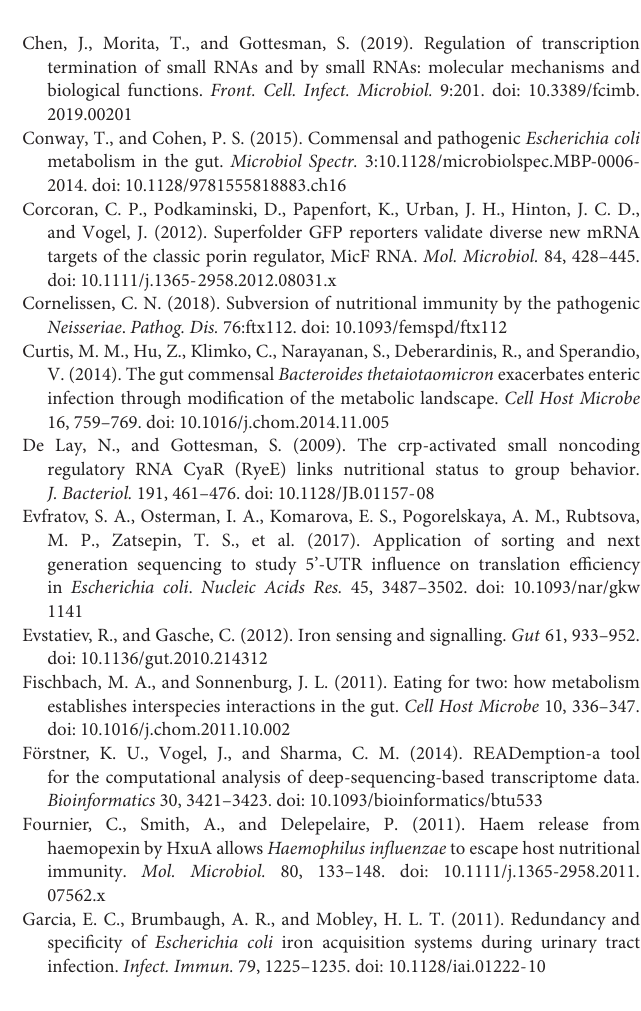
Supplementary Table 1 | Primers, bacterial strains, and plasmids used in this